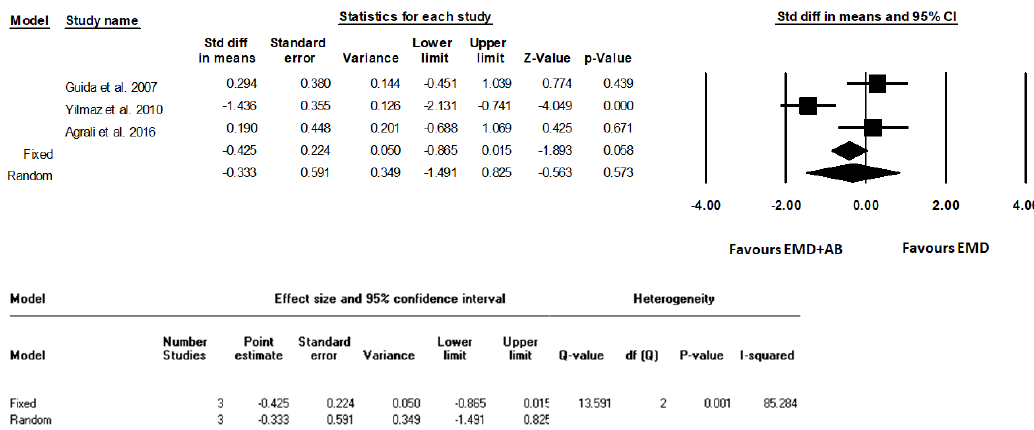
Figure 3. Forest plot from fixed and random effects of meta-analysis evaluating the differences in reduction of probing depth (PDred, mm) after surgical treatment using EMD and autogenous bone or EMD alone (weighted mean difference, 95% CI) with the related heterogeneity analysis.